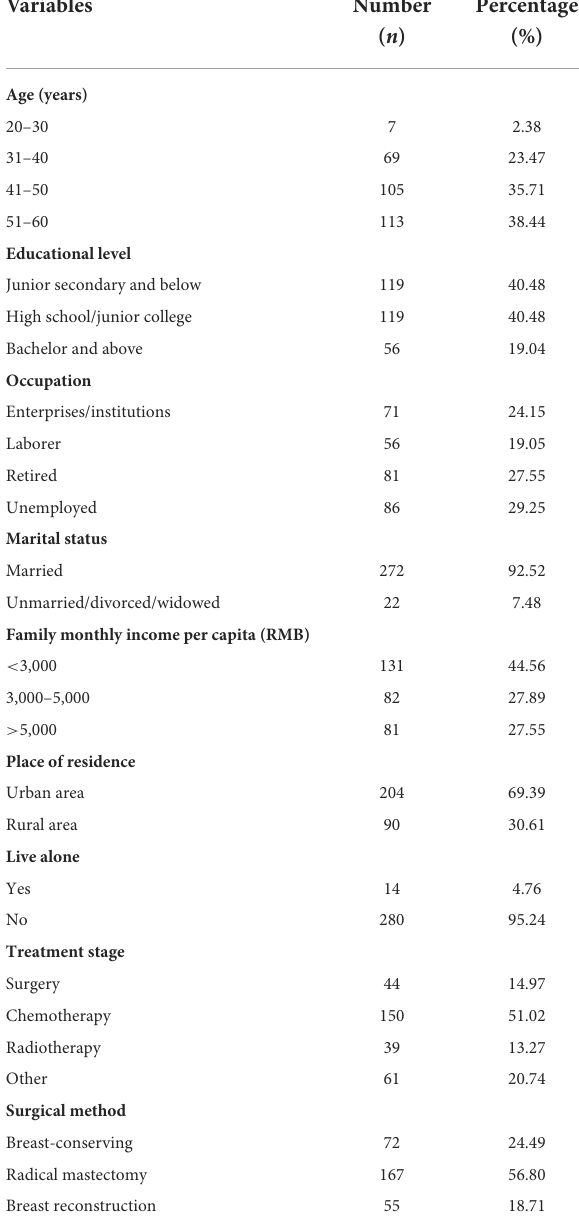
TABLE 1 Demographic characteristics of the patients with breast cancer ( n =